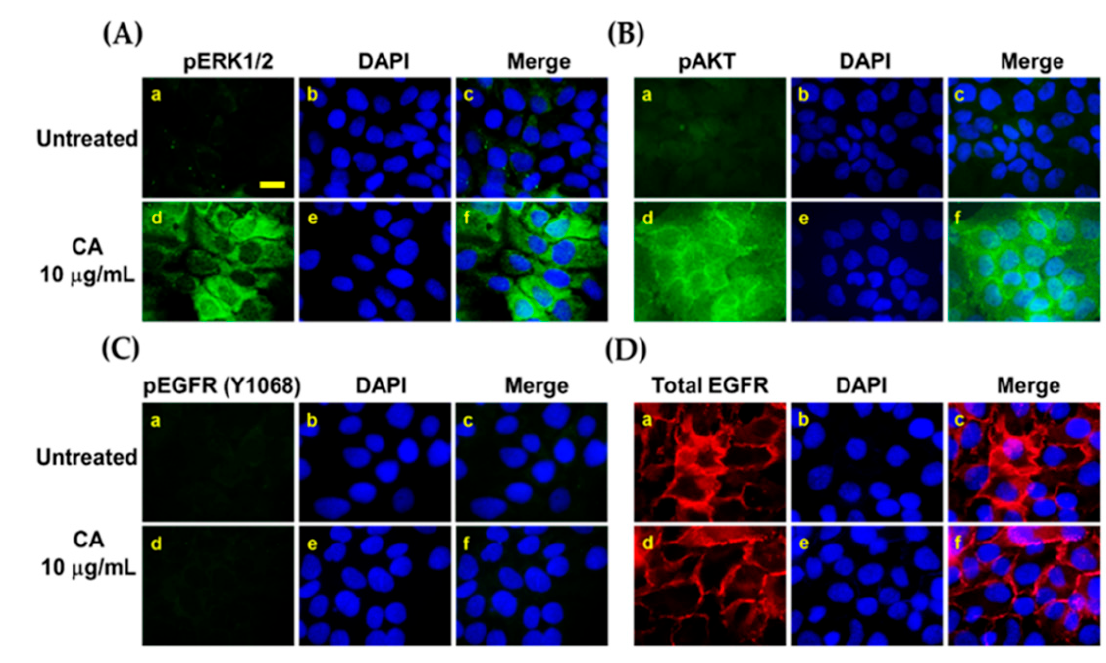
Figure 7. CA extract activated ERK1/2 and Akt phosphorylation in single cells. Immunofluorescence study showing the signal of phosphorylated form of ERK1/2 (green) ( A ) and Akt (green) ( B ) in HaCaT cell treated with 10 µg/mL of CA extract for 15 min. Additionally, phosphorylation status of EGFR at tyrosine 1068 ( C ) and the expression of EGFR protein (red) ( D ) were examined. The nucleus of HaCaT cells were stained with DAPI (blue). Representative pictures were taken by a fluorescent microscope at 100× magnification (scale bar = 200 µm).